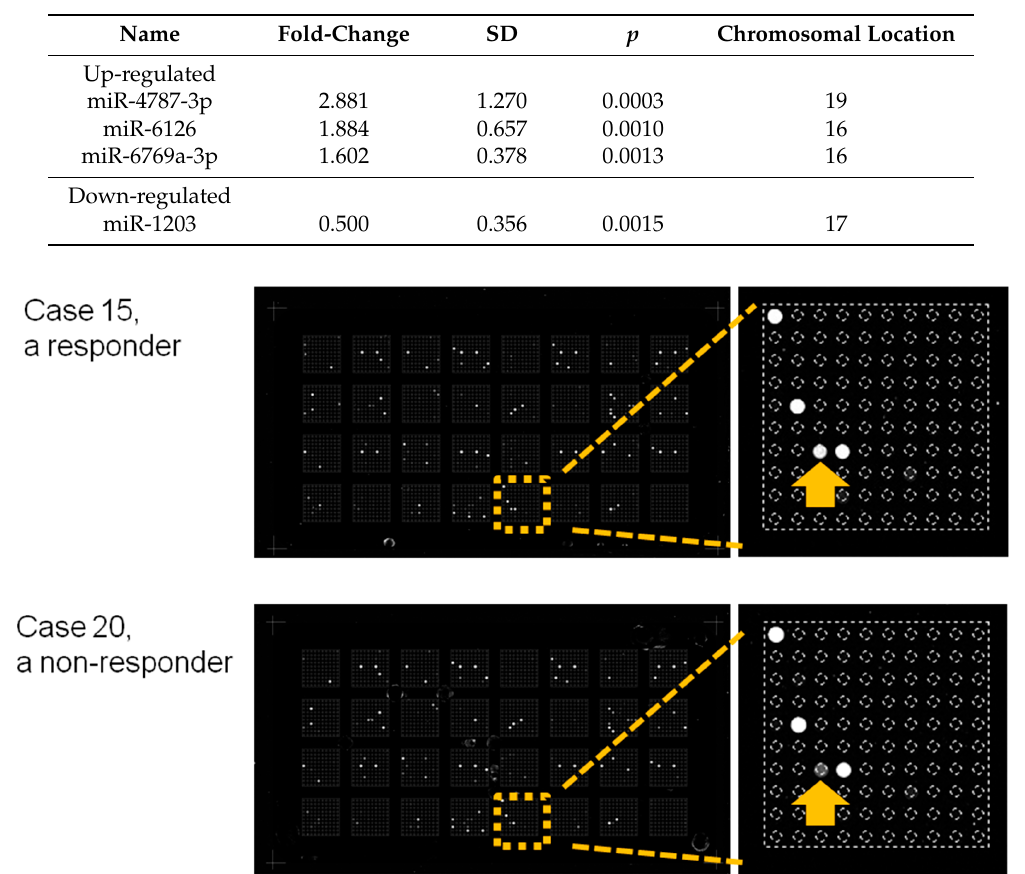
Figure 2. Images of the microarray chips. Sera obtained at week 24 were loaded onto the miRNA microarray chips. Yellow squares indicate blocks in which DNA-probes specific to miR-6126 were added to the microarray chips. The signal corresponding to miR-6126 is depicted by yellow arrows for case 15, a responder; and case 20, a non-responder. The signal intensity of case 15 was stronger, while that of case 20 was weaker.